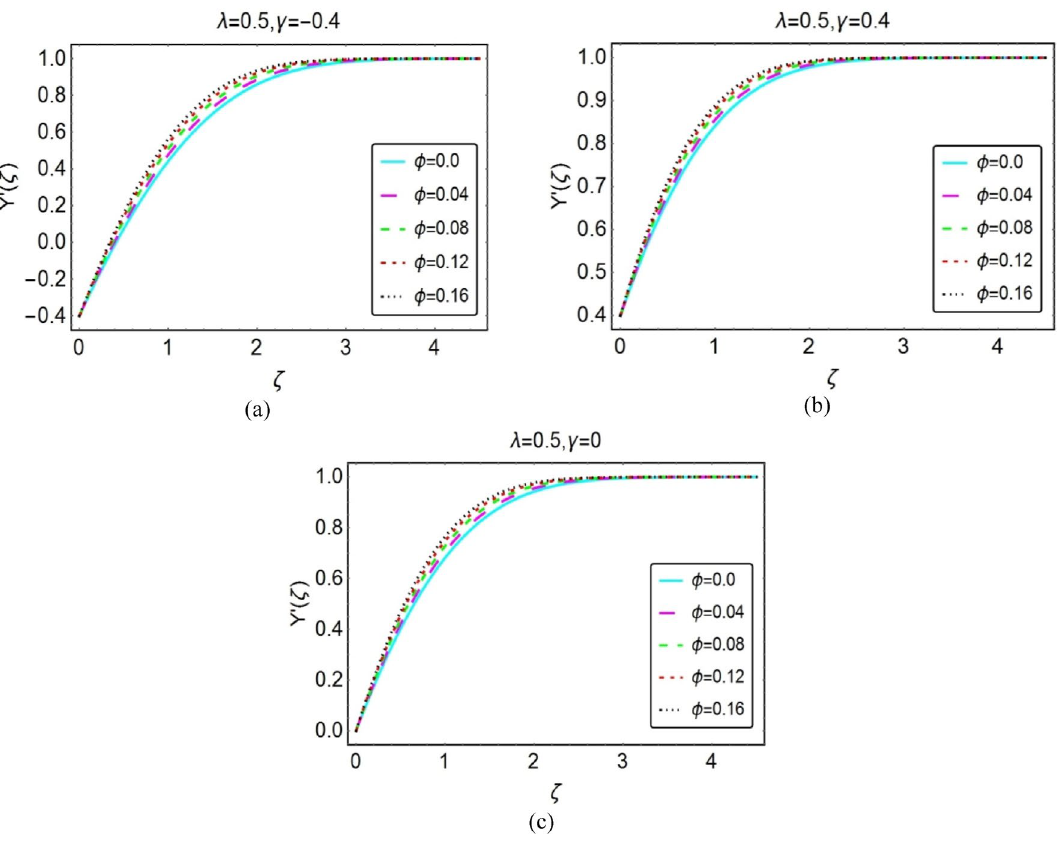
Figure 2. Impacts of φ on Y ′ (ζ) for ( a ) opposing ( b ) assisting and ( c ) static